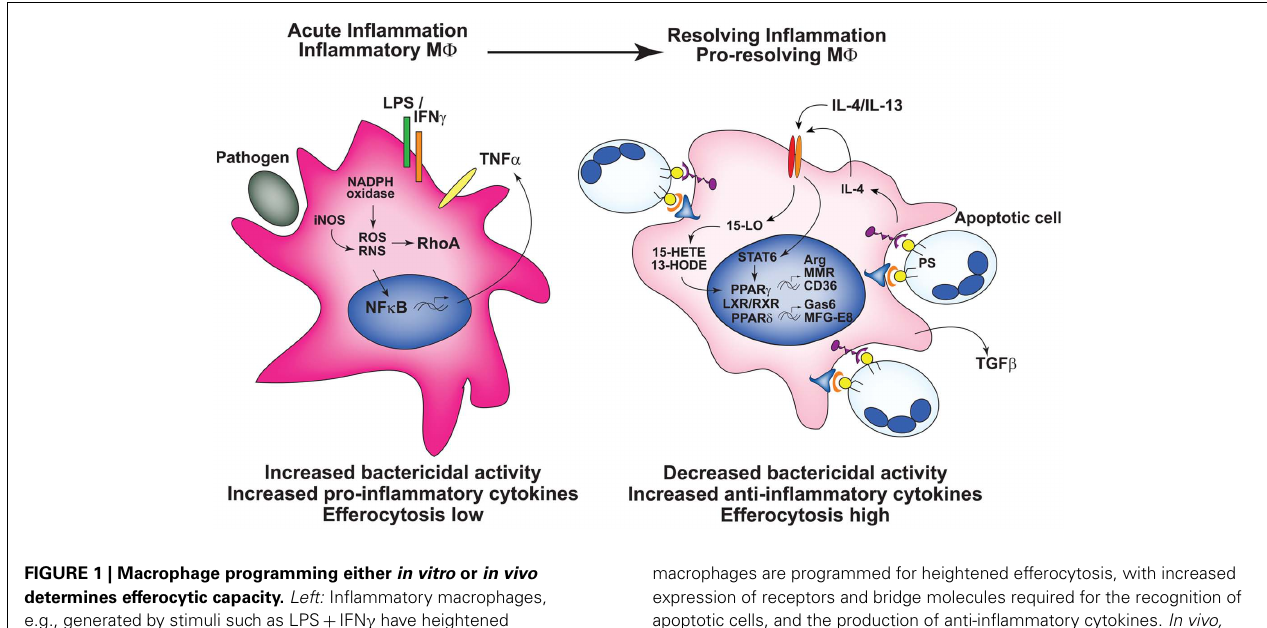
FIGURE 1 | Macrophage programming either in vitro or in vivo determines efferocytic capacity. Left: Inflammatory macrophages, e.g., generated by stimuli such as LPS + IFN γ have heightened bactericidal activity and production of pro-inflammatory mediators, and are programmed poorly for efferocytosis. Right: Following activation of the nuclear receptors, pro-resolving, or resolution-phase